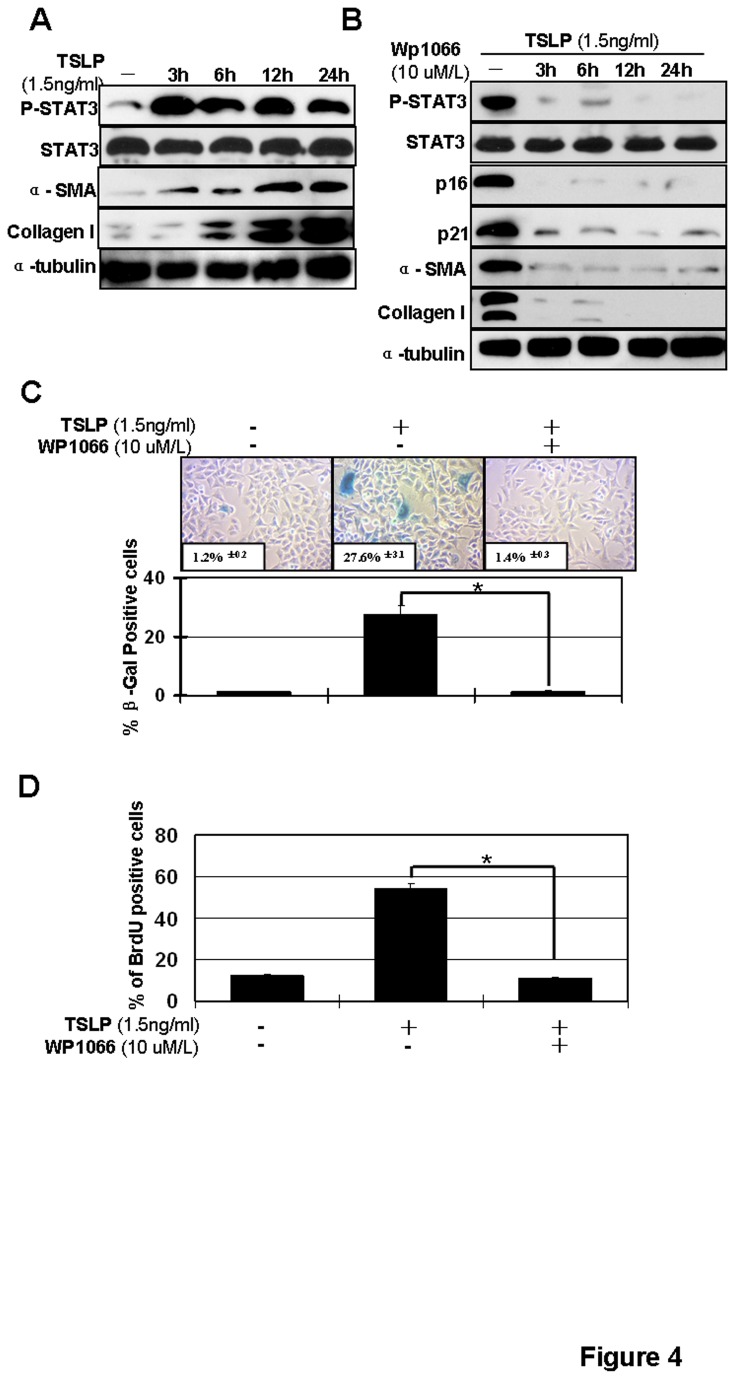
Inhibition of Stat3 overcomes TSLP-induced senescence and airway remodeling in BESA-2B cells.(A) TSLP-induced activation of Stat3 and airway remodeling. BESA-2B cells were stimulated with 1.5ng/ml TSLP and total protein was collected at different time points. Protein expressions of phospho-Stat3, Stat3, α-SMA and Collagen I were analyzed by western blotting along with α-tubulin, which serves as a loading control. BESA-2B cells were stimulated with 1.5ng/ml TSLP and 10μM WP1066 as indicated. (B) Total protein was collected after 6 hour TSLP stimulation. Protein expressions of phospho-Stat3, Stat3, p21, p16, α-SMA and Collagen I were analyzed by western blotting. Expression of α-tubulin, serves as a loading control. (C) Cells were fixed and then stained with SA-β-gal (upper panel) and SA-β-gal positive cells were quantified (*p < 0.05) (low panel). (D) Cells were stained with BrdU (*p < 0.05).